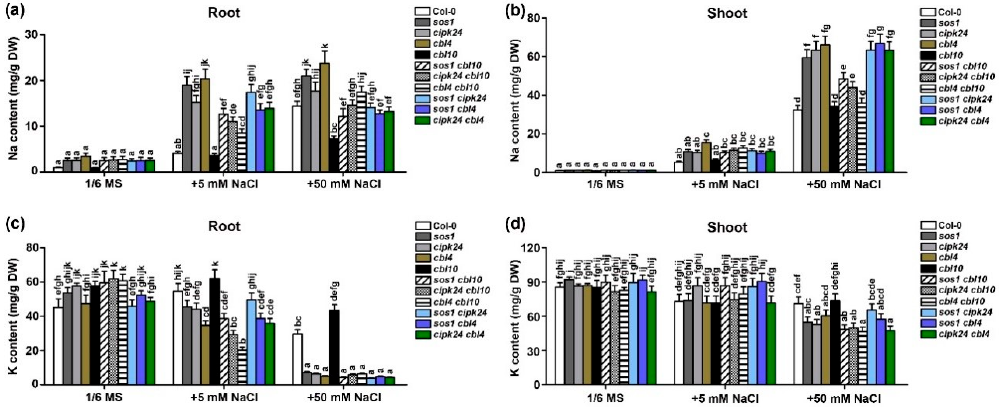
Figure 6. The Na + and K + content in the wild type (Col-0) and various mutants grown under different external Na + conditions. Three-week-old wild type and mutant plants grown in hydroponic 1/6MS solutions containing 0, 5 mM or 50 mM NaCl for five days were harvested for the measurements of the Na + and K + contents. ( a–b ) The Na + content in the root ( a ) and shoot ( b ) under different Na + regimes; ( c–d ) the K + content in the root ( c ) and in the shoot ( d ) under different Na + regimes. Data are presented as the mean ± SE of triplicate experiments. Values labeled with different letters are significantly different ( p < 0.05).